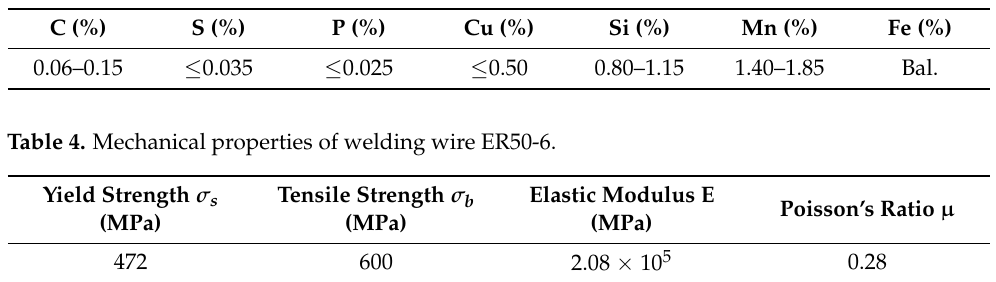
Table 3. Chemical composition of welding wire ER50-6.